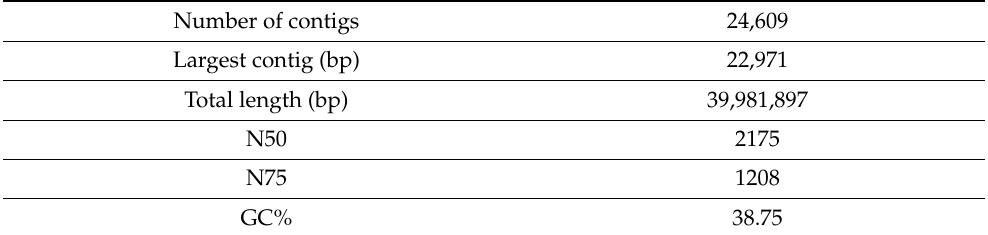
Table 2. Statistics of RNA-seq assembly.